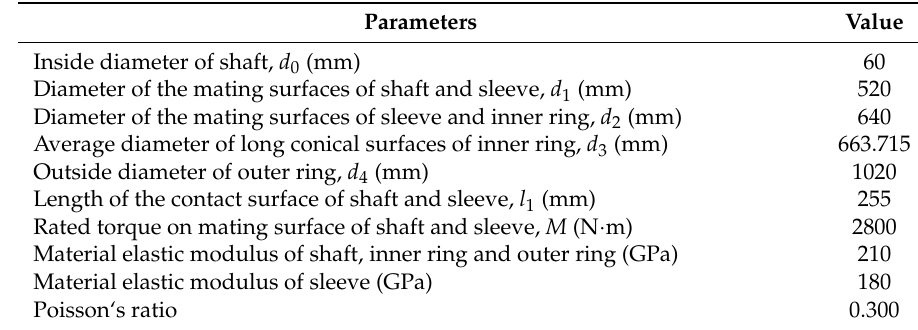
Table 2. Parameters of wind turbine shrink disk.